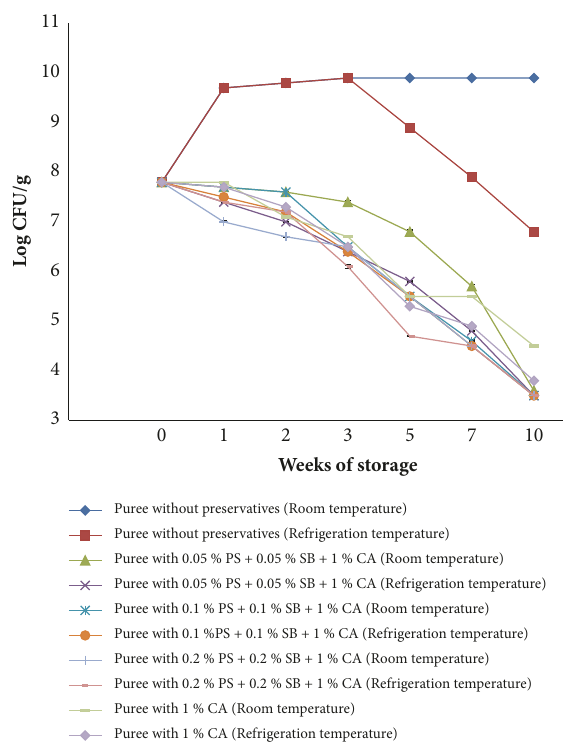
Figure 3: Growth of E. coli in OFSP puree with preservatives during storage at ambient temperatures (15-25 ∘ C) and refrigeration temperature (4 ∘ C). PS : potassium sorbate, SB : sodium benzoate, and CA : citric